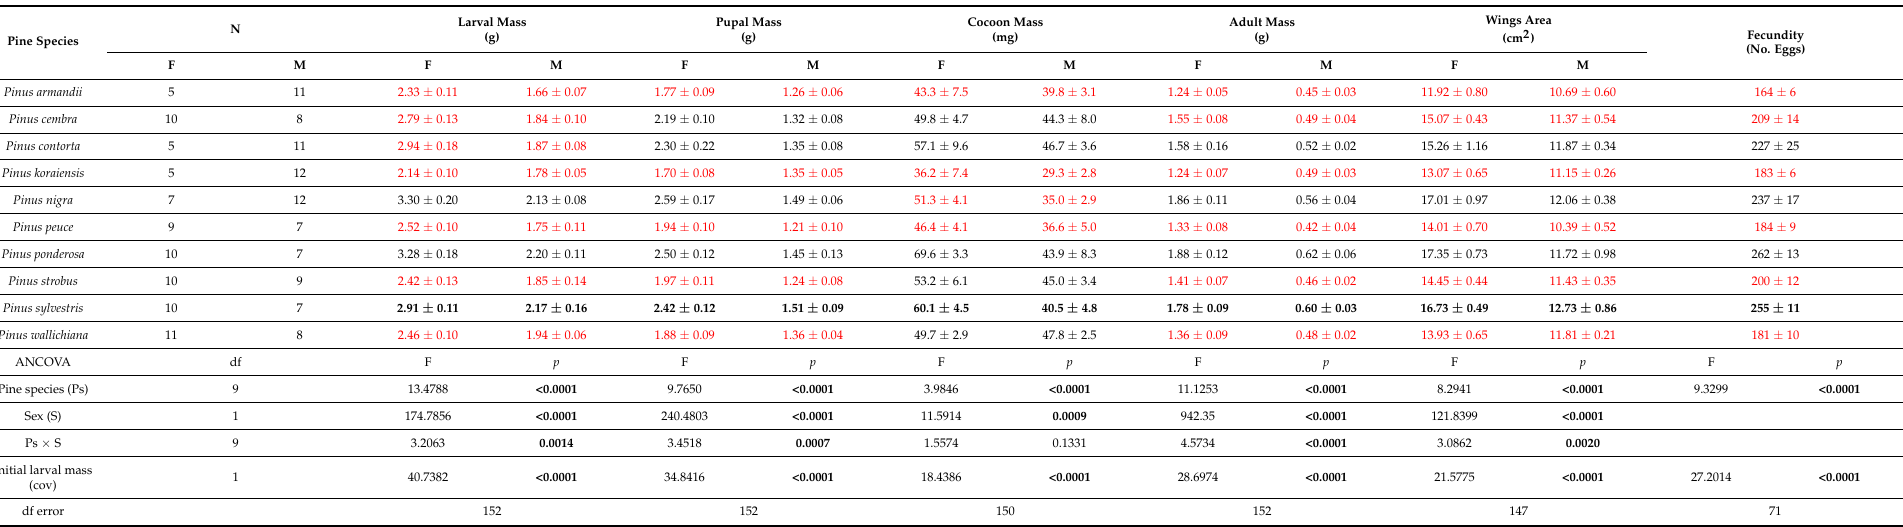
Table A1. Means and standard errors ( ± SE) of masses of larvae, pupae, cocoons, and adults, as well as wing area and fecundity for individuals of the pine lappet ( Dendrolimus pini L.) fed with needles of different pine species. A two-way covariance analysis was used to present the effects of the pine species (Ps) and sex and their interactions. The initial larval mass, i.e., the body mass of the larvae on the starting day of the experiment, was used as covariant. Statistically significant differences p < 0.05 are marked in bold. Mean values marked in red mean that they are significantly lower than the value for the individuals fed with primal host Pinus sylvestris L. needles (bolded; Dunnett’s test used here; α = 0.05), and black—non-significant differences. The Dunnett’s test was performed for the Ps factor, so there was no sex differentiation, thus two cells (for female and male) are marked in